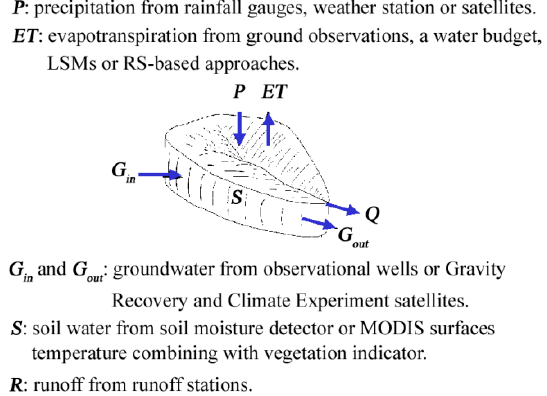
Figure 1. The access methods of the water balance components within a drainage basin.